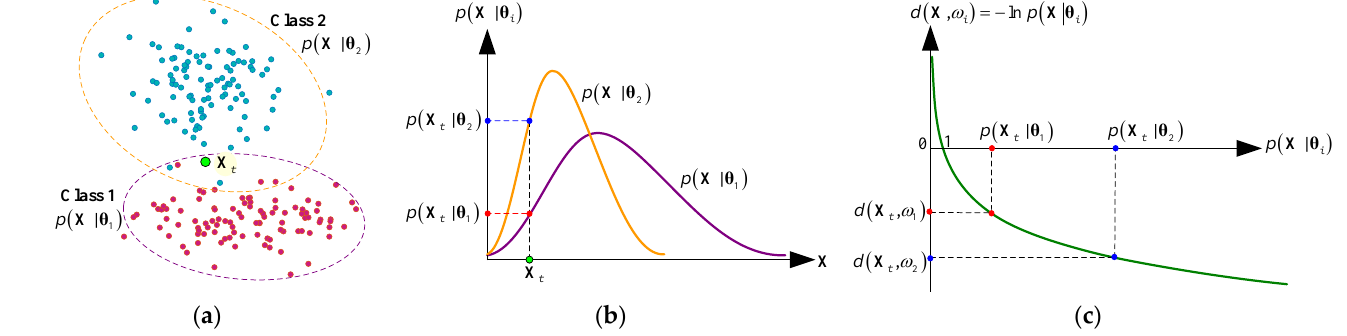
Figure 4. Illustration of ML distance; ( a ) Data points of X t and two classes; ( b ) Likelihood values for X t ; ( c ) NLL values (ML distances) for X t .